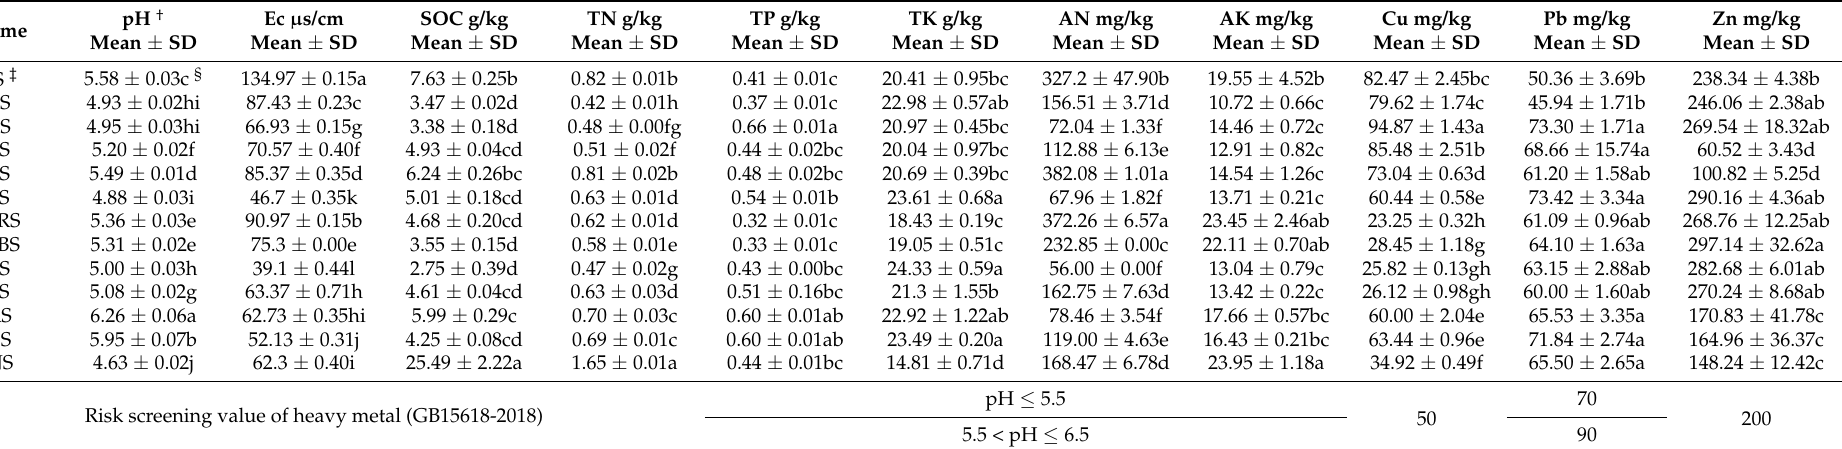
Table 1. Chemical characteristics of soil samples (rhizosphere and bulk soil) from iron mine tailing in Jiangxi.